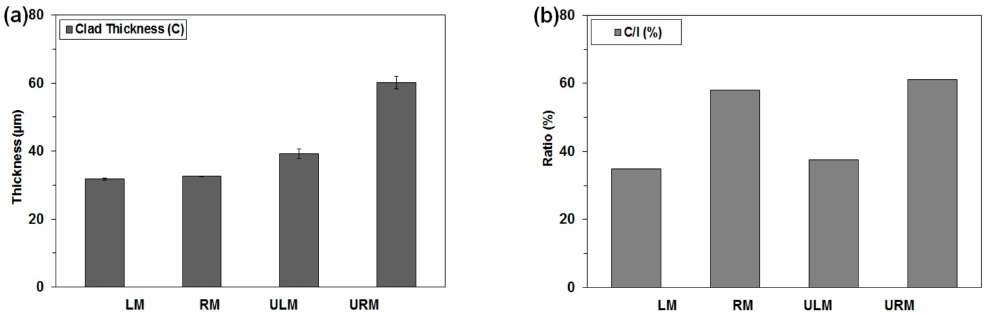
Figure 1. Variation of ( a ) composite clad layer thickness ( C ) and ( b ) ratio of clad layer thickness to initial preplaced powder thickness ( C / I ) with laser processing conditions.